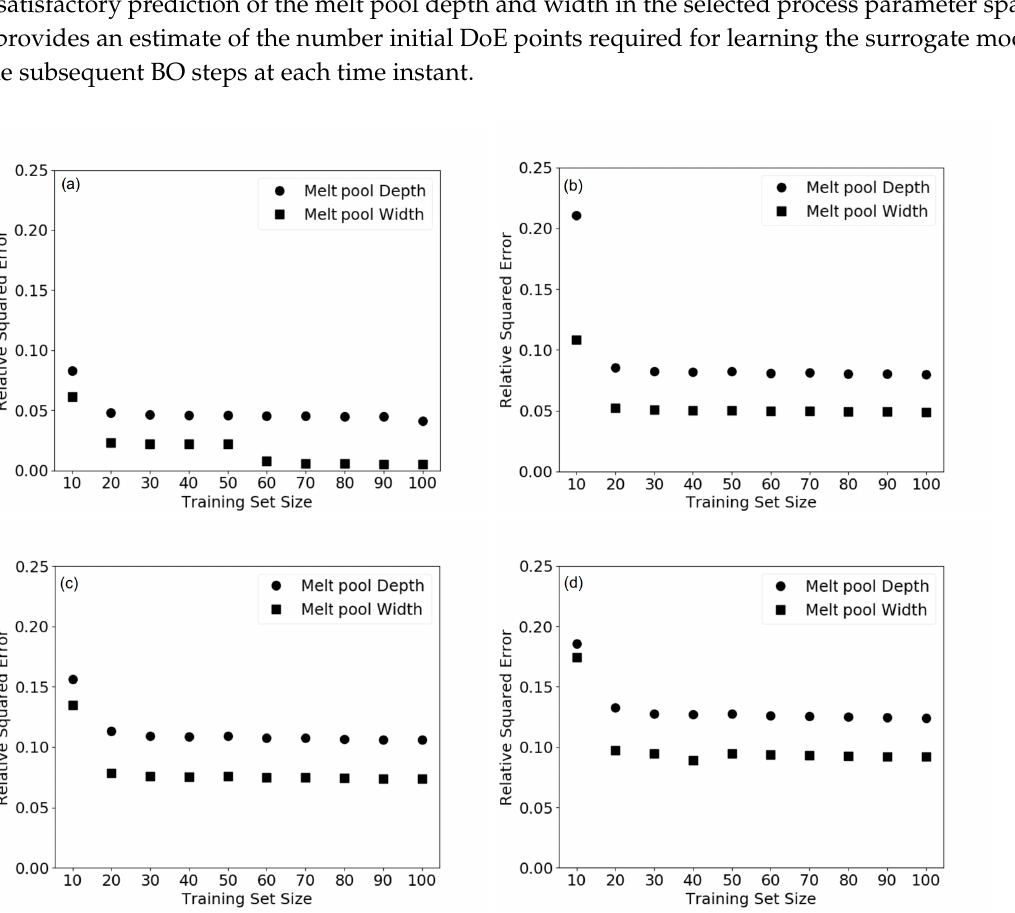
Figure 8. Relative Squared Error in prediction of melt pool depth and width at ( a ) t = 2 s, ( b ) t = 5 s, ( c ) t = 10 s, and ( d ) t = 20